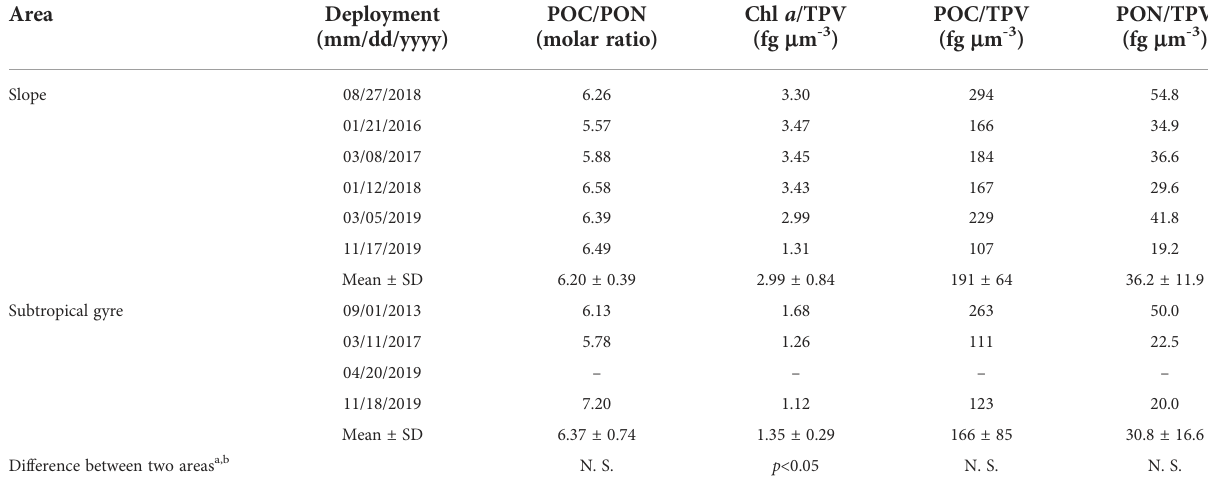
Difference between two areas a,b N. S. p <0.05